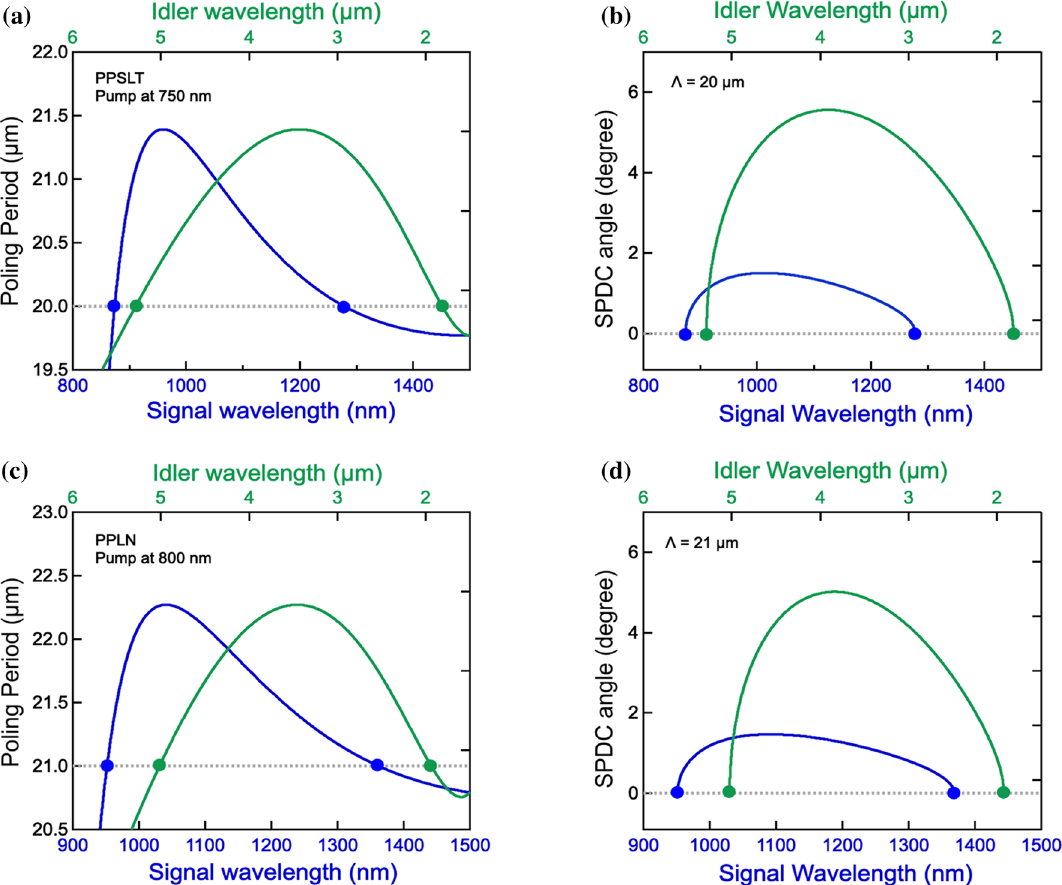
Figure 3. Theoretical calculations of the optimized QPM conditions for simultaneous SPDC in PPSLT ( a , b ) and PPLN ( c , d ). Polling periods in the collinear process are represented by the vertical axes for the optimized conditions in PPSLT ( a ) and in PPLN ( c ), where pump wavelengths are set to 750 nm and 800 nm, respectively. In ( a ), with the periodicity of 20 µm, two pairs (Pair 1: 880 nm and 5.2 µm. Pair 2: 1280 nm and 1.8 µm) are simultaneously quasi-phase-matched in the same condition. In ( c ), with the periodicity of 21 µm, two pairs (Pair 1: 950 nm and 5 µm. Pair 2: 1360 nm and 2 µm) are simultaneously quasi-phase-matched in the same condition. Figure ( b ), ( d ) show the corresponding non-collinear QPM curves. The vertical axes represent the output angles of the SPDC photons. In ( b ), for the pump at 750 nm, all photons within output angles of 5.7° are produced in the range of 1.8–5.2 µm. In ( d ), for the pump at 800 nm, all photons within output angles of 5.2° are produced in the range of 2–5